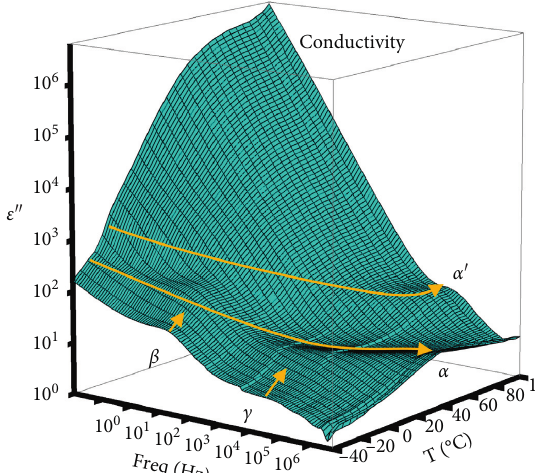
Figure 5: 3D plot of the imaginary permittivity for